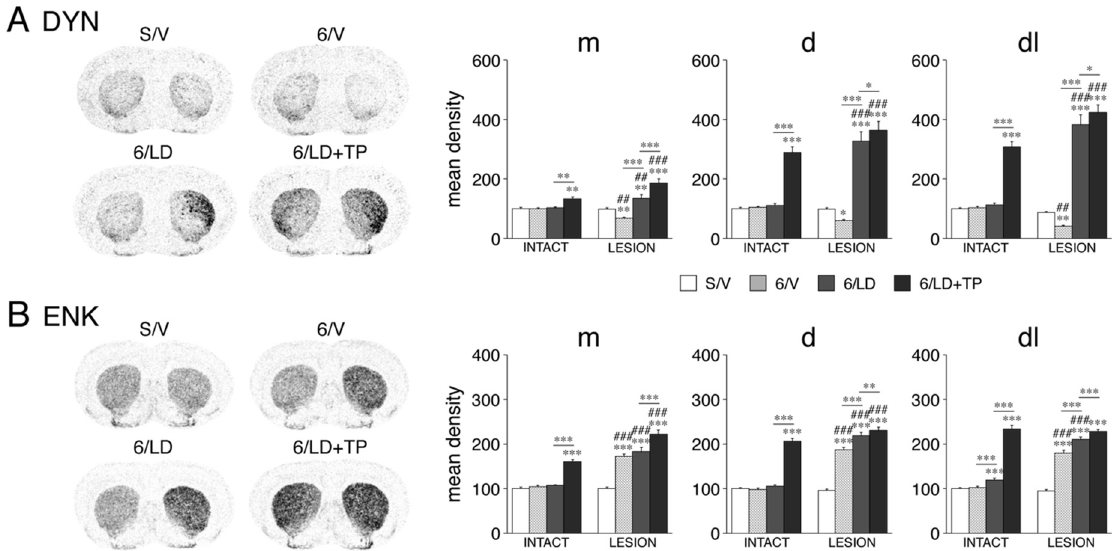
Figure 2. Changes in expression of dynorphin ( A ) and enkephalin ( B ) in the striatum after dopamine depletion and repeated treatment with L-DOPA and the PDE10A inhibitor TP-10 in adults. Illustra- tions of film autoradiograms (left) show the expression of dynorphin (DYN) and enkephalin (ENK) in sections from the mid-striatal level in sham controls (S/V), after a 6-OHDA lesion (right hemi- sphere) only (6/V), after dopamine depletion followed by repeated L-DOPA treatment (6/LD) or after dopamine depletion followed by repeated L-DOPA plus TP-10 treatment (6/LD + TP). Changes in expression (mean density values, mean ± SEM) (right) for dynorphin or enkephalin in rats of the S/V, 6/V, 6/LD and 6/LD + TP groups are given for the medial (m), dorsal (d) and dorsolateral (dl) sectors on the side ipsilateral (LESION) and contralateral (INTACT) to the lesion, on the middle striatal level. The values are normalized relative to values in sham controls (S/V, intact side). * p < 0.05, ** p < 0.01, *** p < 0.001 vs. S/V or as indicated; ## p < 0.01, ### p < 0.001 vs. same group on intact